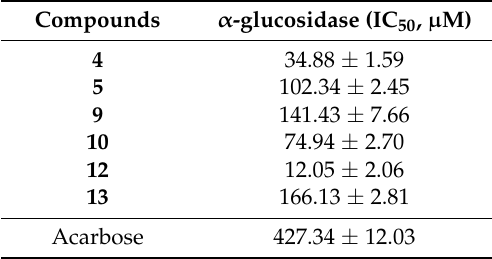
Table 3. α -Glucosidase inhibitory activities of compounds 4 , 5 , 9 , 10 , 12 and 13